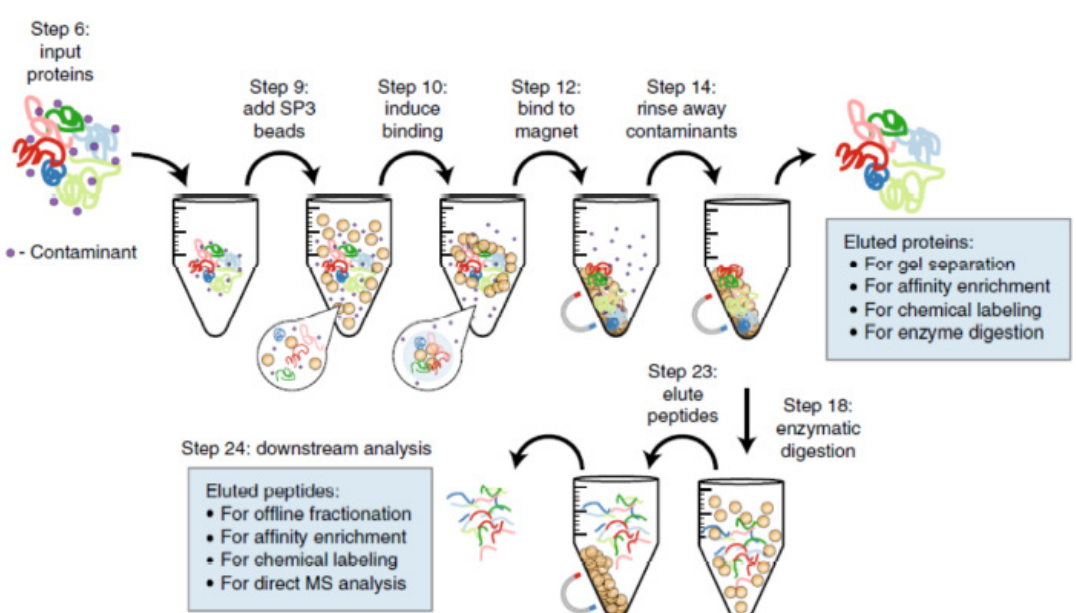
Figure 4. Single pot solid phase-enhanced sample preparation (SP3) for proteomic analysis. Reproduced from reference [81].